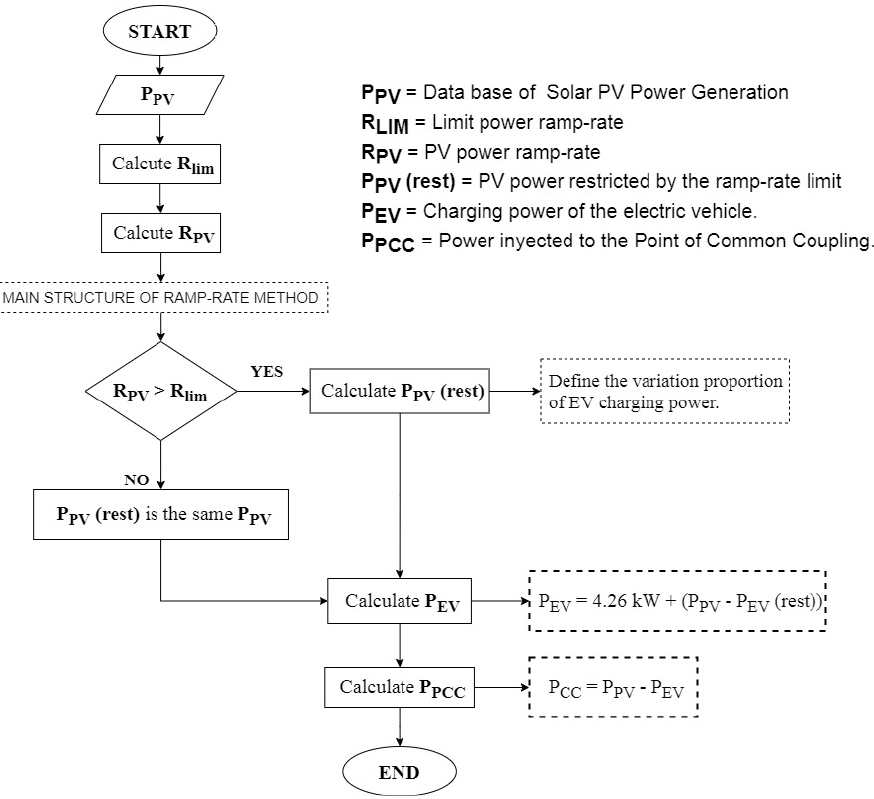
Figure 3. Algorithm for photovoltaic power ramp-rate control.